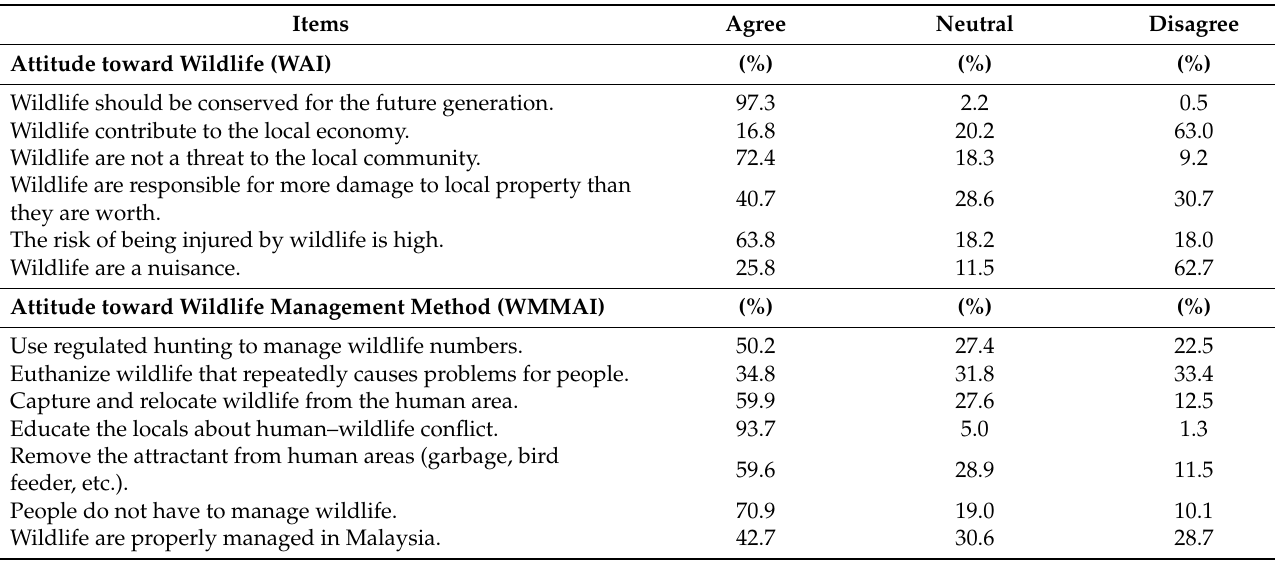
Table 4. Locals’ attitudes toward wildlife and their management